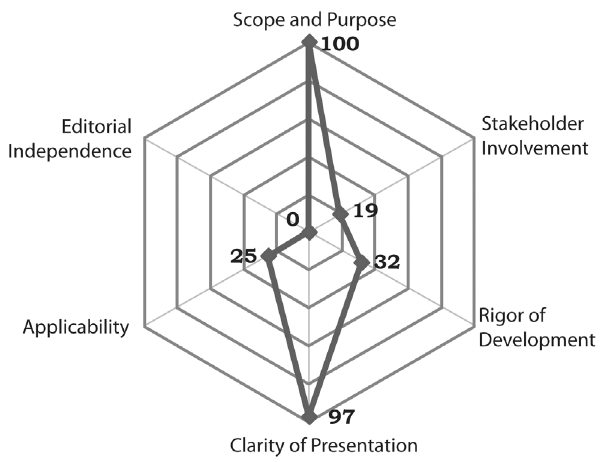
Figure 1. Median scores of evaluated guidelines in five domains of AGREE II instrument.